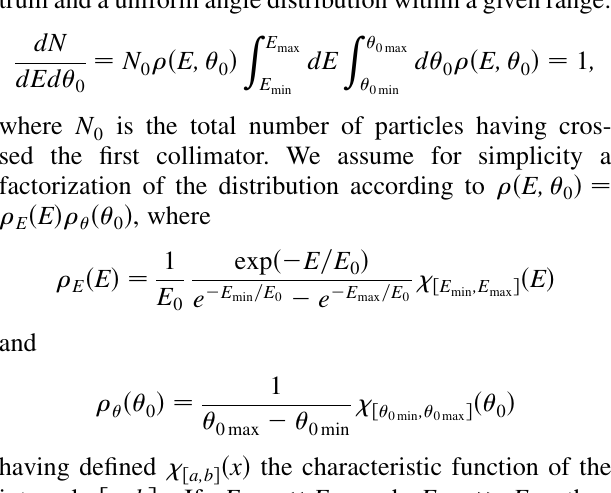
ð E Þ = 1 . The spectrum is obtained for an 0 ¼ 0 : 001 . Lower 0min ¼ 0 : 005 . In this case the 0min